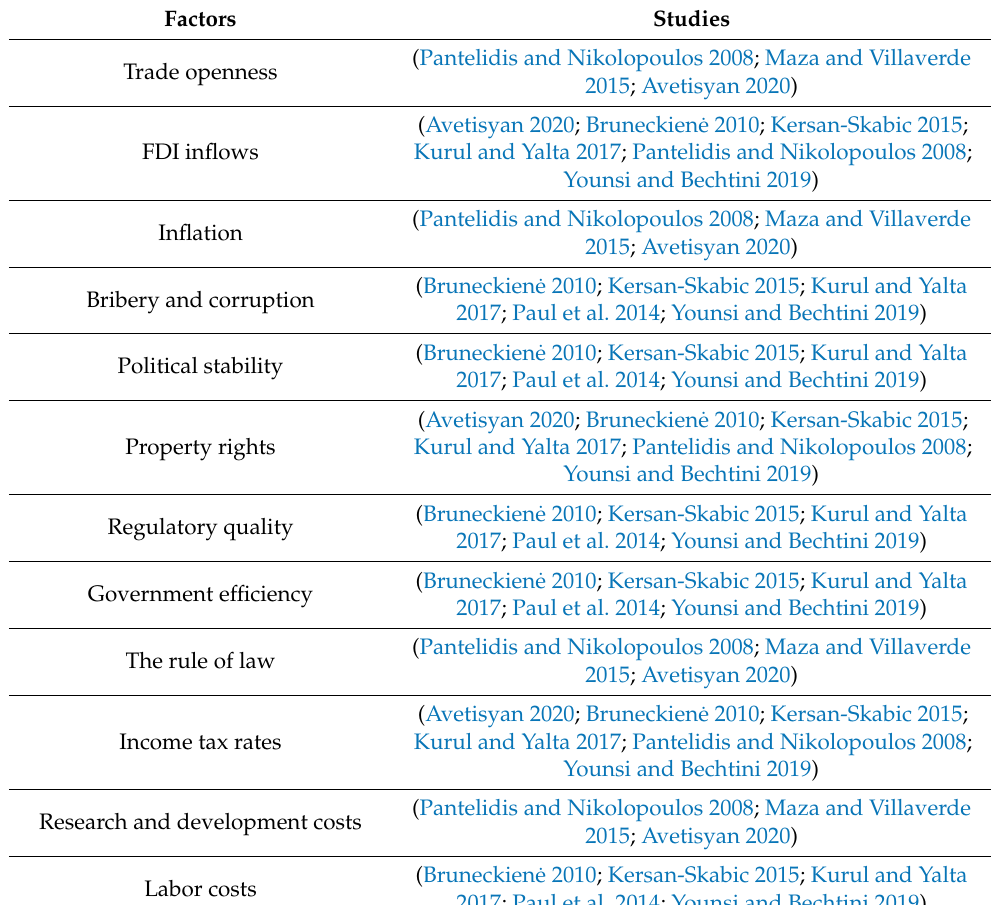
Table 2. Cont. Factors Studies Trade openness